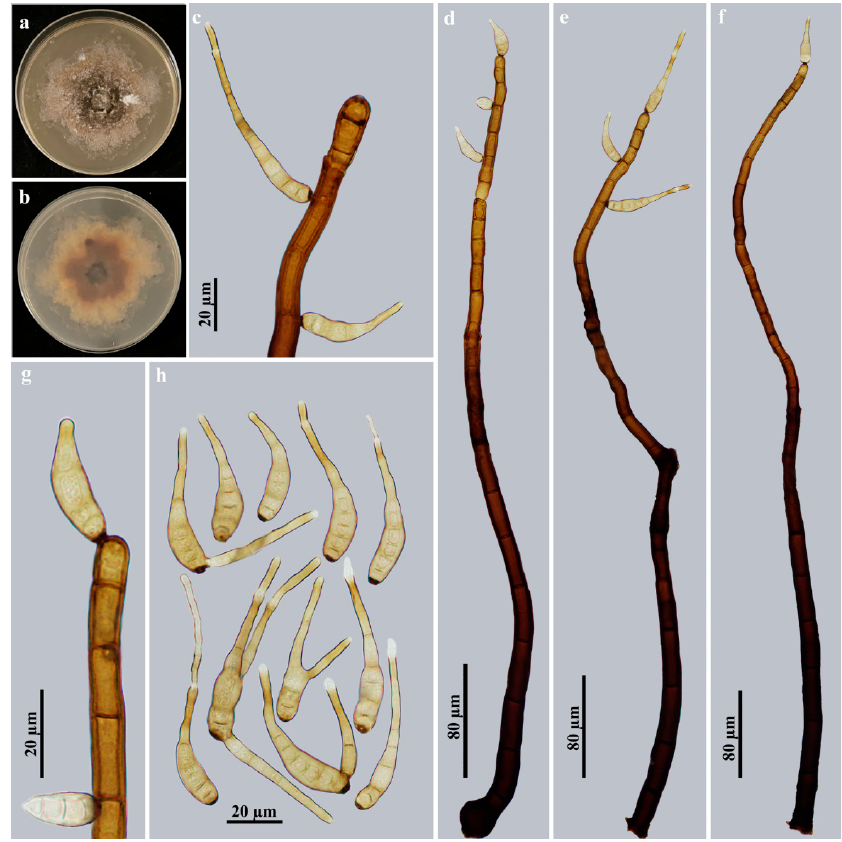
Figure 4. Helminthosporium meilingense (HJAUP M1076, holotype): ( a ) surface of colony after 4 weeks on PDA; ( b ) reverse of colony after 4 weeks on PDA; ( c,g ) conidiogenous cells and conidia; ( d – f ) conidiophores, conidiogenous cells and conidia; ( h ) conidia.